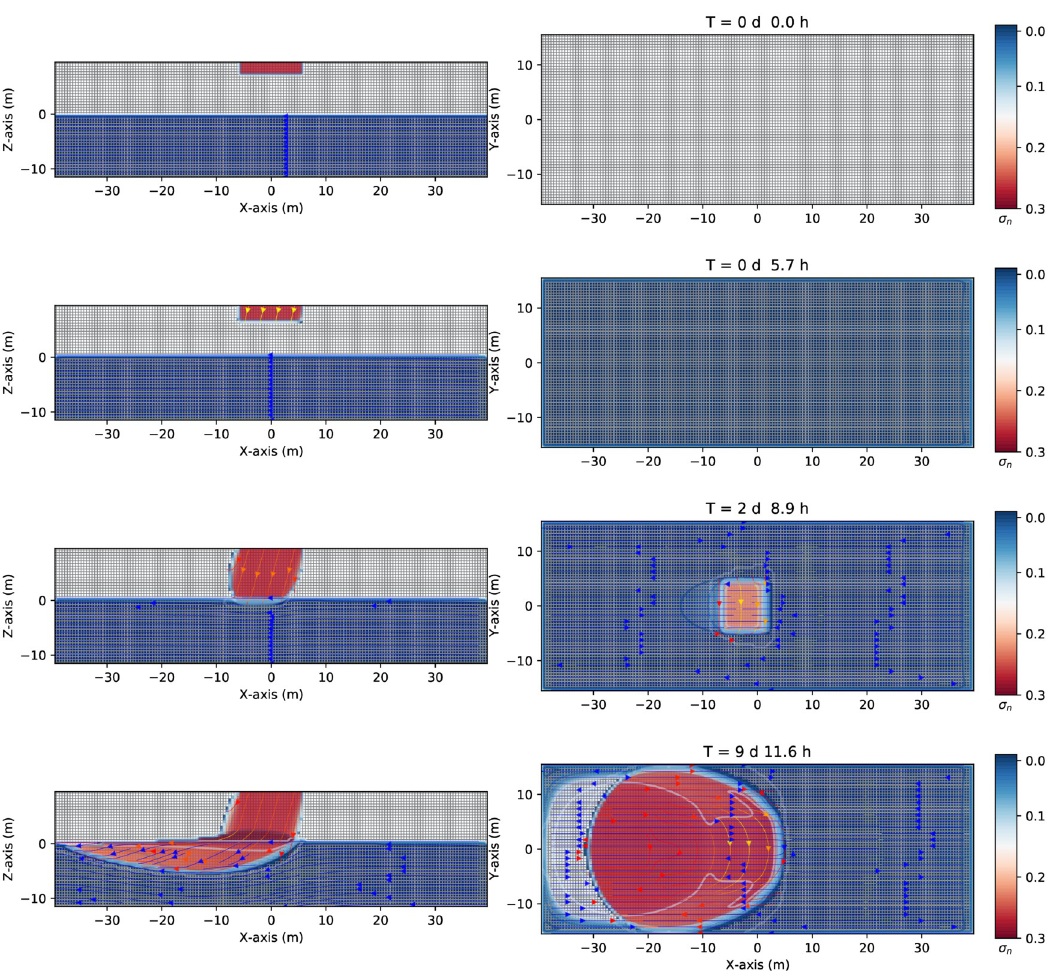
Fig 2. Saturation contours of LNAPL (continuous source) at different times. Three-dimensional numerical results on the saturation contours ( σ = S ) of a three-phase immiscible fluid flow (water + a continuous source of LNAPL + air) using a spatial n n ϕ grid resolution of 0.50 m and a grid dimension of 80 m × 32 m × 22 m , at different times. Left-hand side shows the saturation contours in the ( z − x ) plane. Right-hand side shows the saturation contours in the ( y − x ) one. Notice how the LNAPL moves in the unsaturated zone, although initially, it goes a bit down with respect to the groundwater table (-5 m) being a continuous contaminant spill. On the other hand, the first two rows show no contamination since the plane is located at the groundwater